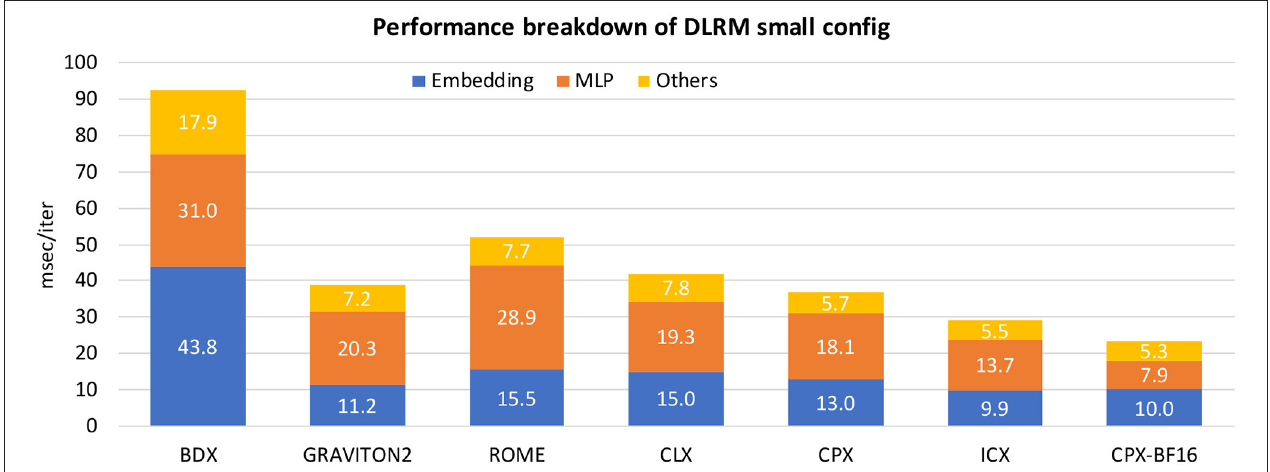
FIGURE 24 | DLRM performance breakdown of small config on multiple platforms.